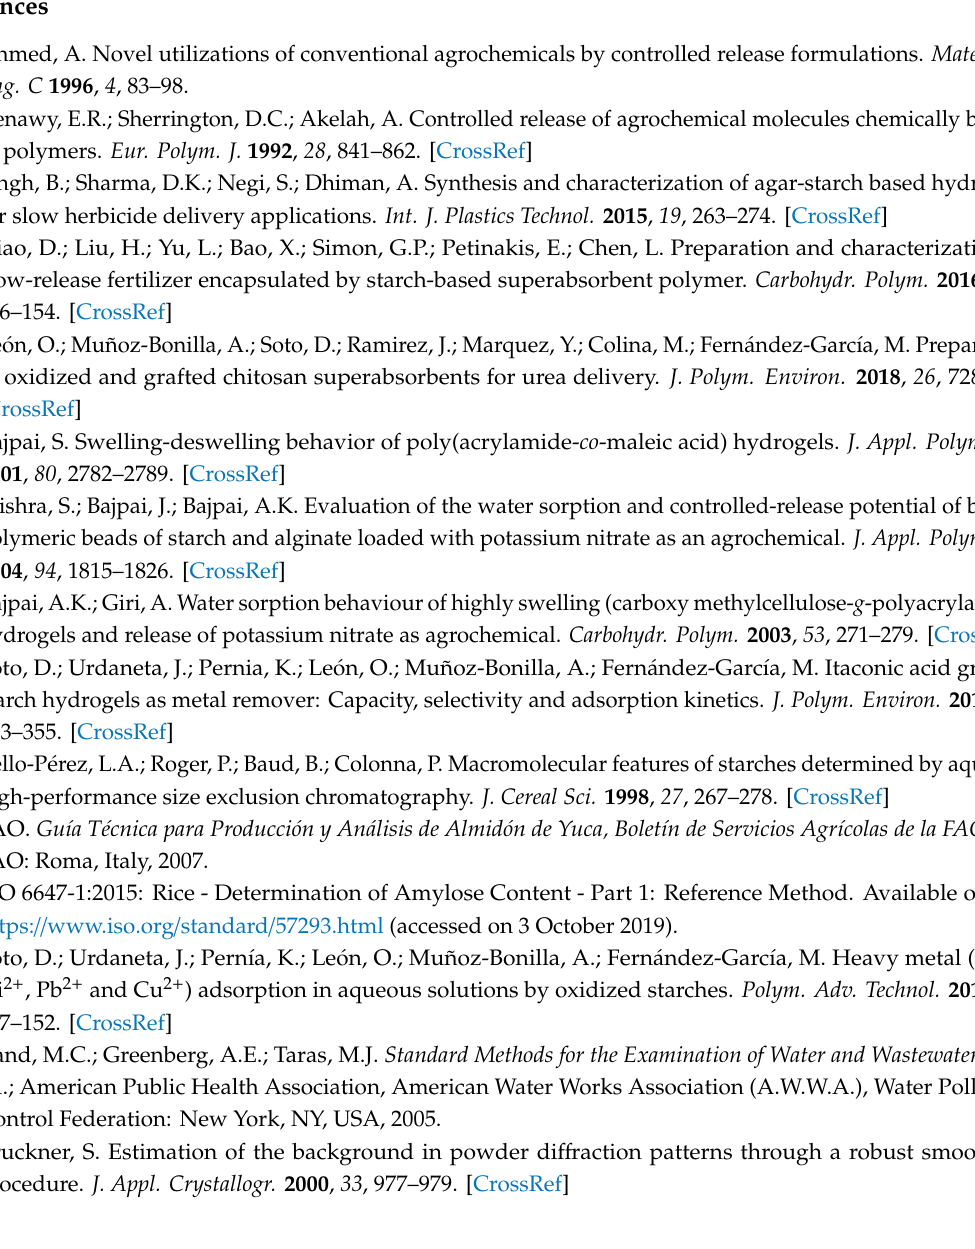
Figure S1: Swelling equilibrium of grafted copolymer CCS as a function of salt concentration for di ff erent salts, Figure S2: Swelling equilibrium of grafted copolymer CMES as a function of salt concentration for di ff erent salts, Figure S3: Swelling equilibrium of grafted copolymer CMUS as a function of salt concentration for di ff erent salts, Table S1: Thermal parameters of native and grafted starch